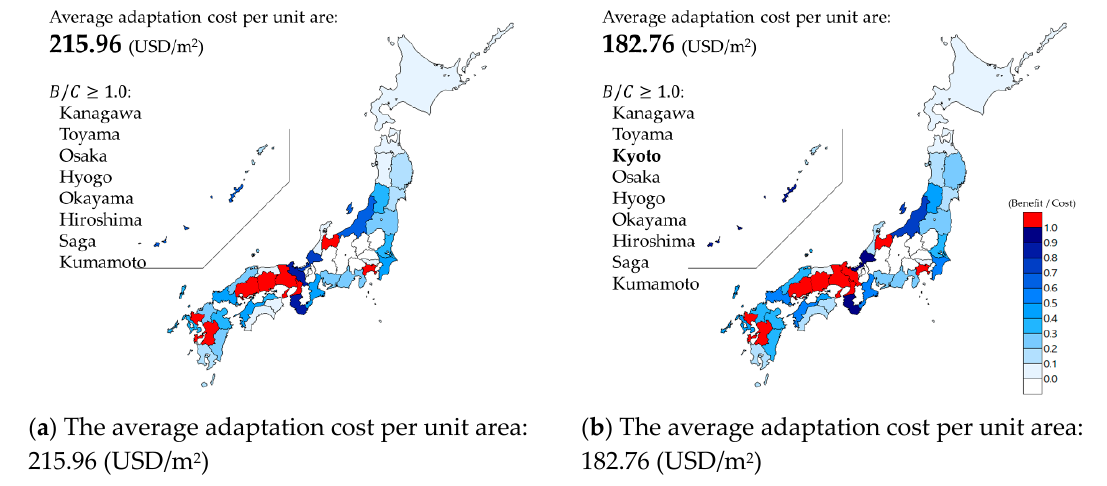
Figure 9. Comparison of cost–benefit ratios of two adaptation scenarios for RCP8.5 in 2081–2100 .